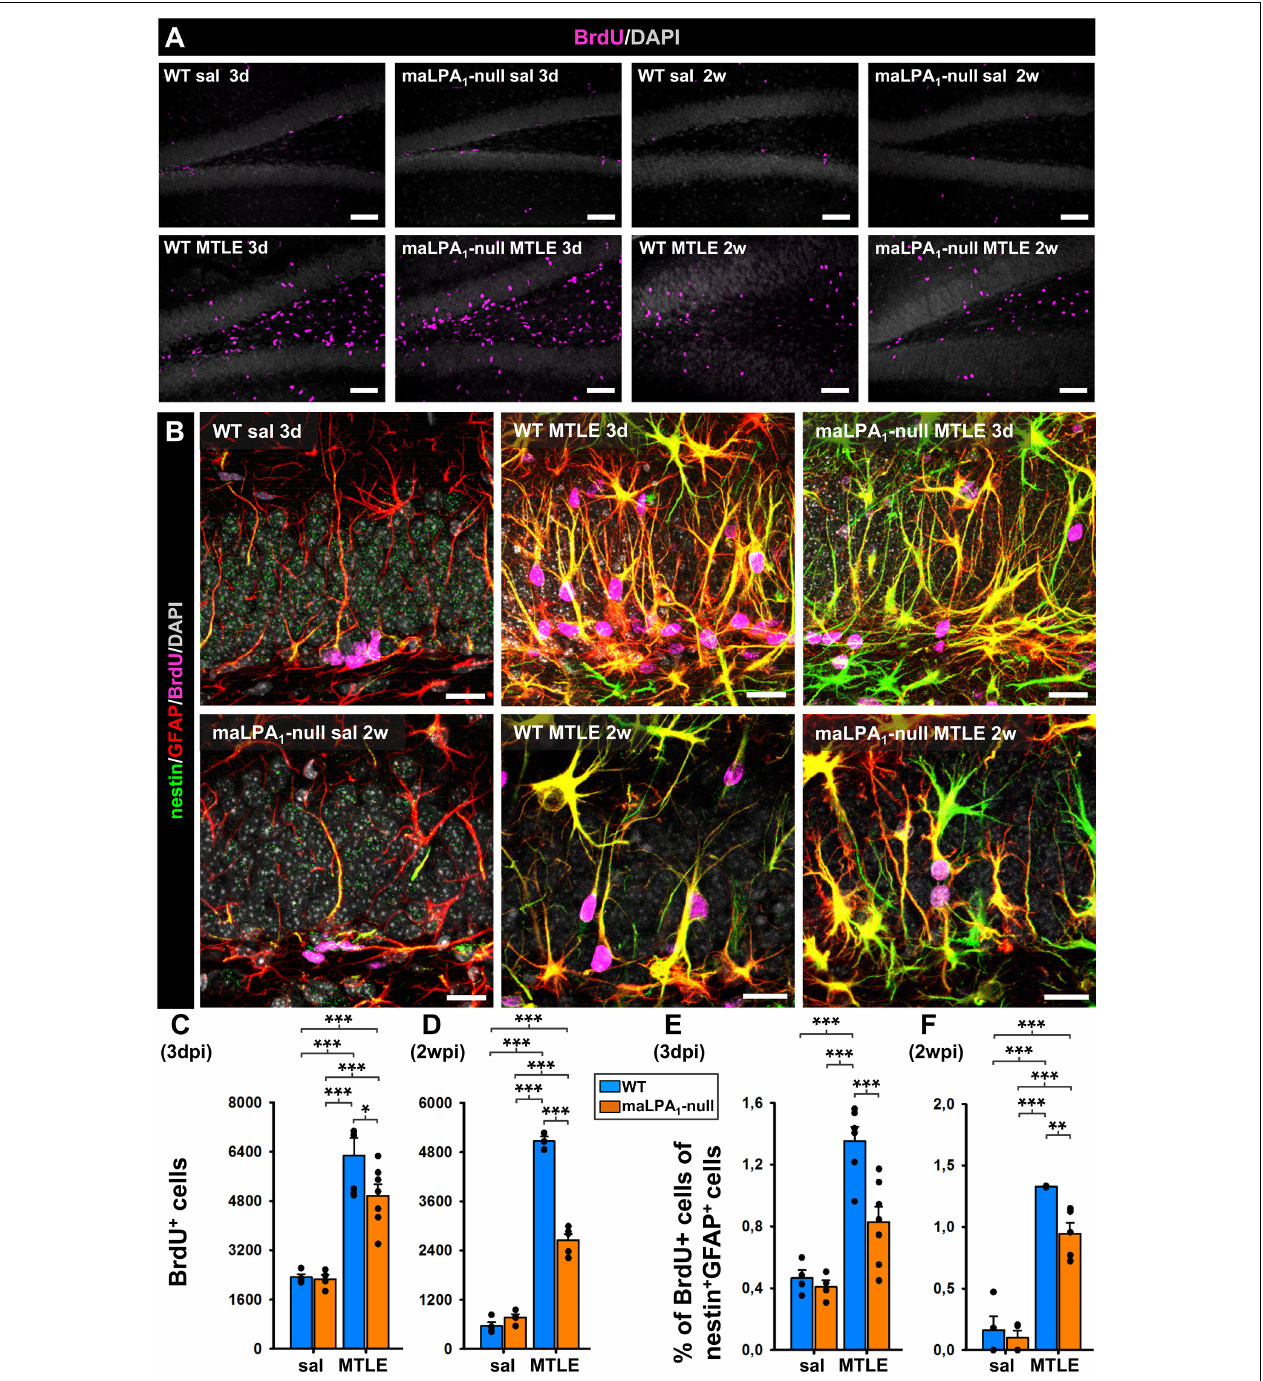
FIGURE 4 | Absence of LPA 1 reduces the massive activation of React-NSCs. WT and maLPA 1 -null mice were subjected to the model of MTLE (or the corresponding control) and then were administered BrdU (four injections, 2 h apart) on the second day after the saline/KA intrahippocampal injection. The mice were sacrificed 3 days or 2 weeks after surgery. We proceeded to quantify the total number of BrdU cells in the DG (A) and the proportion of dividing (BrdU + ) NSCs and React-NSCs (B) by confocal microscopy. The number of BrdU cells was much higher in MTLE mice, but it was reduced in the maLPA1 compared to the WT at 3 days (C) . These differences were more evident at the 2-week time point (D) . At 3 days, the proportion of dividing (BrdU + ) NSCs among total NSCs (identified by expression of nestin and GFAP) did not change in the control (saline) group. In MTLE WT mice the proportion of dividing NSCs was much higher than in any sal group but was reduced (without difference to sal levels) in the MTLE maLPA 1 -null mice (E) . 2 weeks after the induction of MTLE, the number of dividing NSCs in the MTLE maLPA 1 -null mice was also significantly reduced compared to the MTLE WT mice (F) , although in this case both MTLE groups were higher than the sal groups. Scale bar is 50 mm in (A) and 20 mm in (B) . Data were analyzed by a two-way ANOVA. Post hoc Holm–Sidak was used to analyze differences between WT, maLPA 1 -null, sal, and MTLE groups. * p < 0.05, ** p ≤ 0.005, *** p ≤ 0.001.